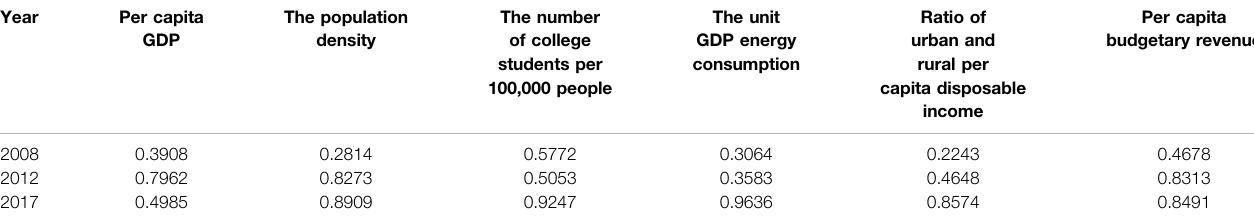
TABLE 6 | Impact of elements to coupling coordination degree between urbanization and eco-environment.